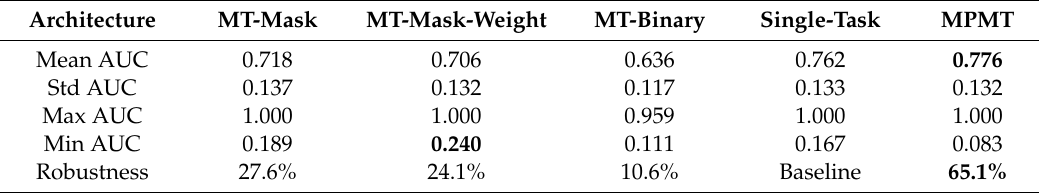
Table 6. Comparison of deep neural architectures for human targets including Multiple Partial Multi- Task